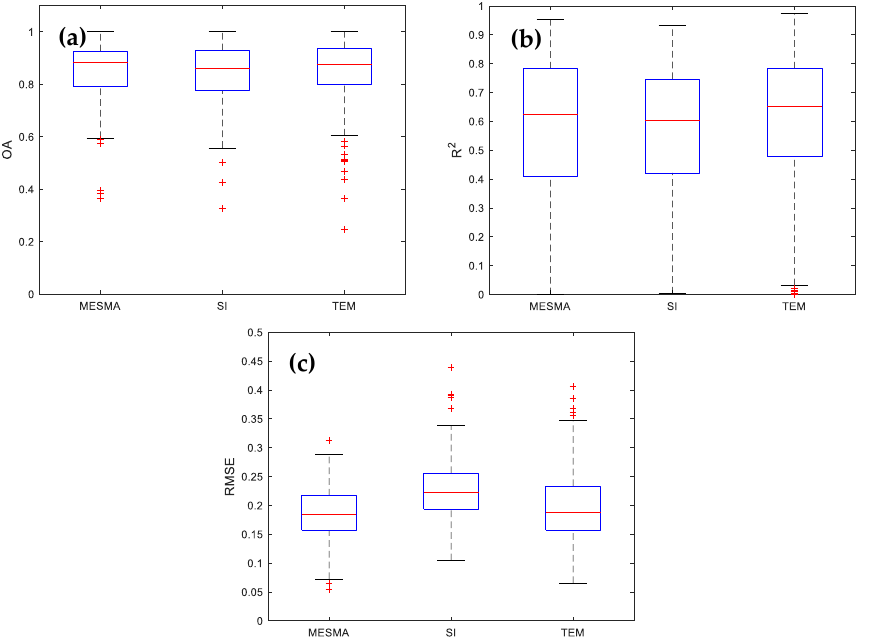
Figure 8. Boxplots of accuracy evaluation results for the three AVHRR/2 FSC retrieval algorithms from 1 km aggregation to 5 km scale: ( a ) the RMSE of the three AVHRR/2 FSC retrieval algorithms at 1 km aggregation to 5 km scale; ( b ) the R 2 of the three AVHRR/2 FSC retrieval algorithms at 1 km aggregation to 5 km scale; ( c ) the OA of the three AVHRR/2 FSC retrieval algorithms at 1 km aggregation to 5 km scale.